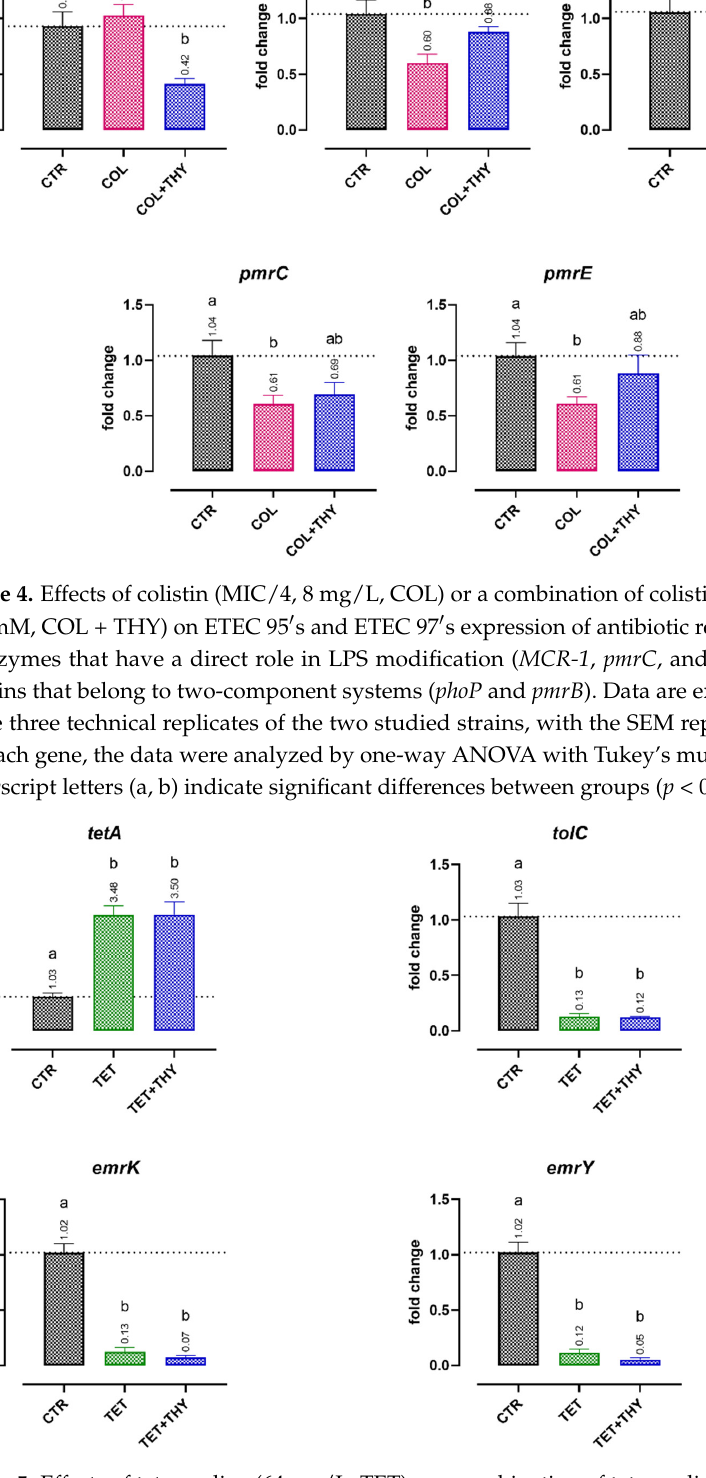
ences between groups ( p < 0.05).